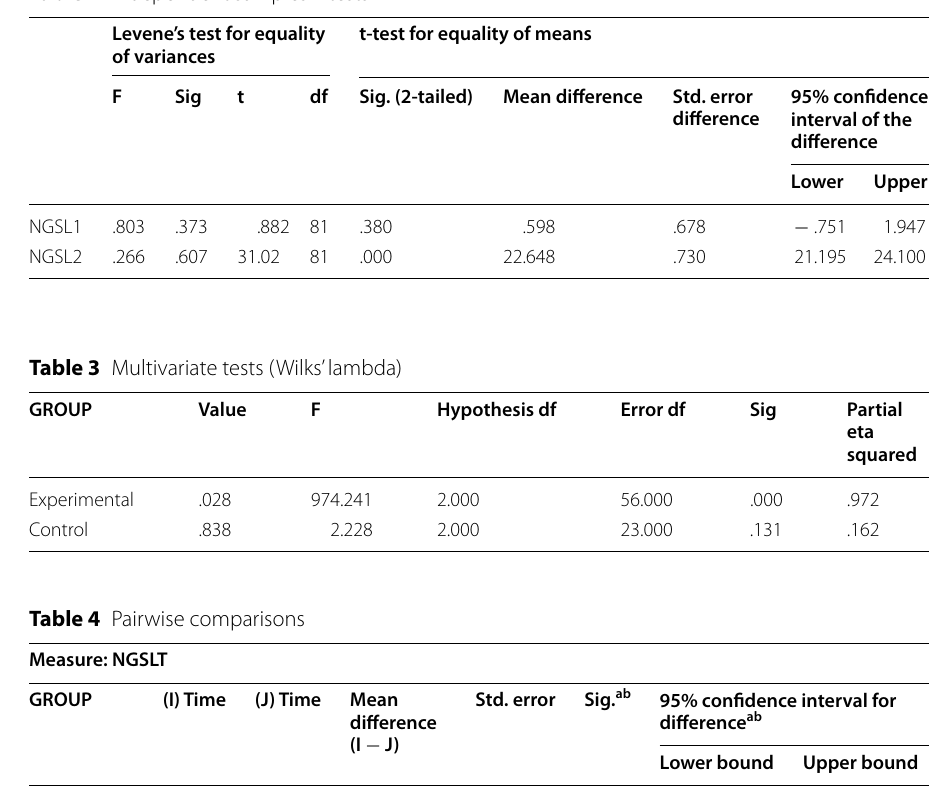
Table 2 Independent samples T-tests Levene’s test for equality of variances